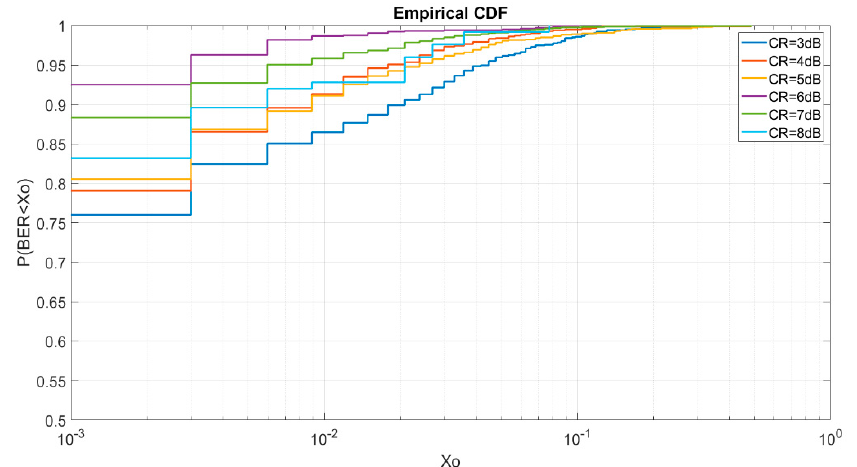
Figure 9. 12W SC-FDE CR sweep CDF.